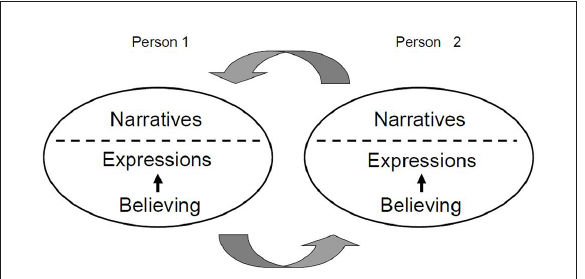
FIGURE2 Interpersonal exchange of personally relevant